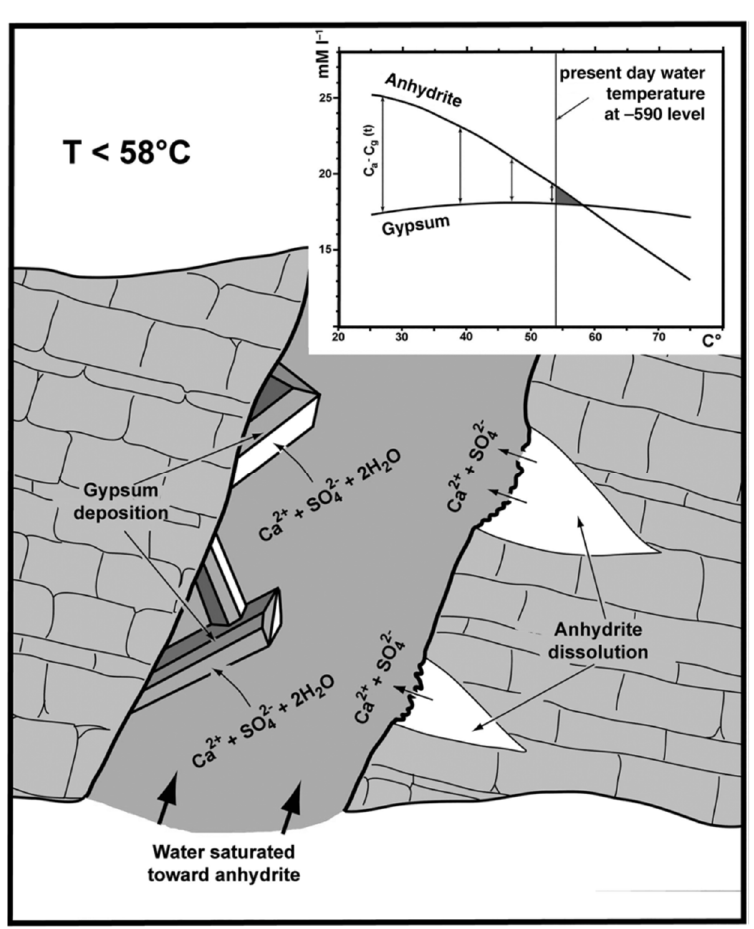
Figure 10. Anhydrite–gypsum relationship in a supersaturated solution (from Forti 2017, fig. 6).